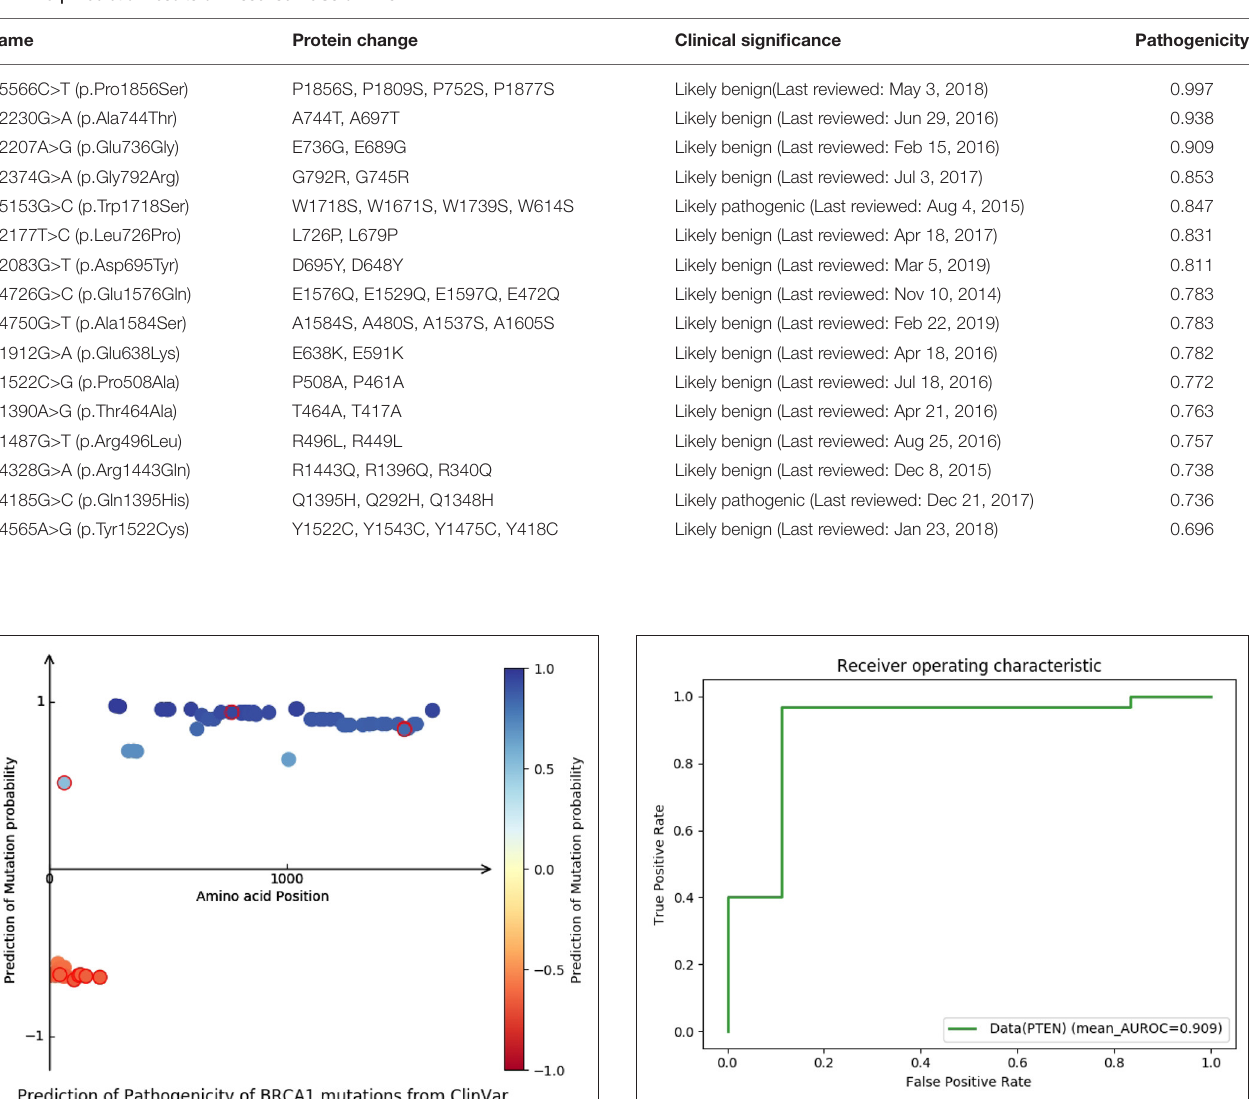
TABLE 5 | Prediction results of missense VUSs of BRCA1.